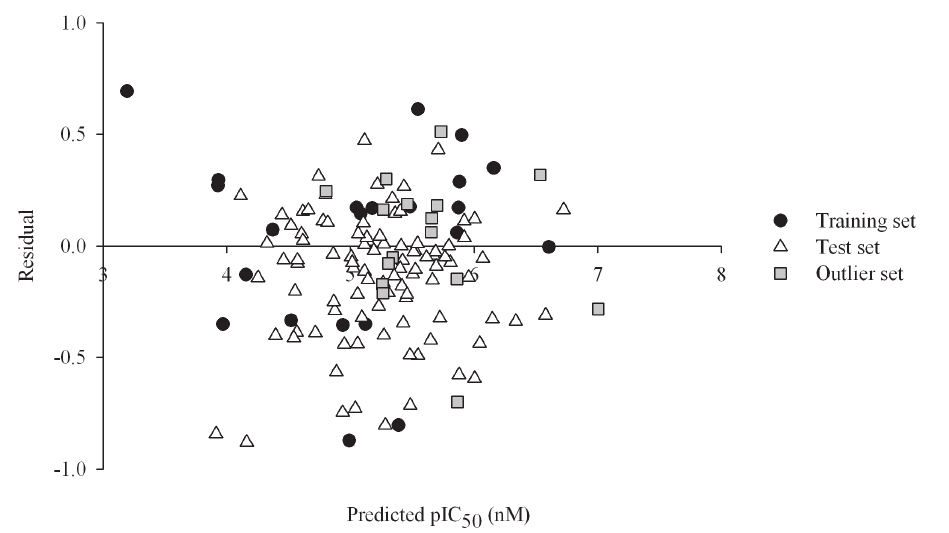
Figure 8. Residual vs . predicted pIC 50 values. Residual vs . the pIC 50 predicted by PhE/SVM in the training set (filled circles), test set (open triangles), and outlier set (gray squares).